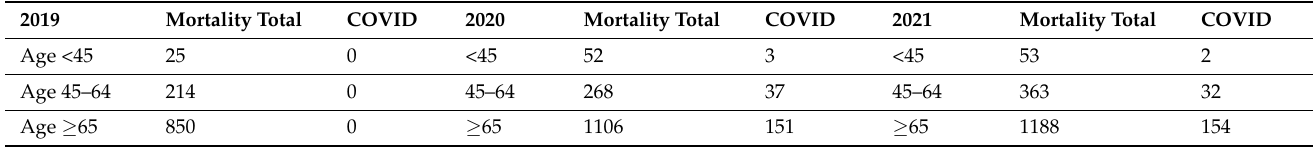
Table 4. Basal data on the total mortality and COVID-19 mortality in 2019, 2020, and 2021 in relation to